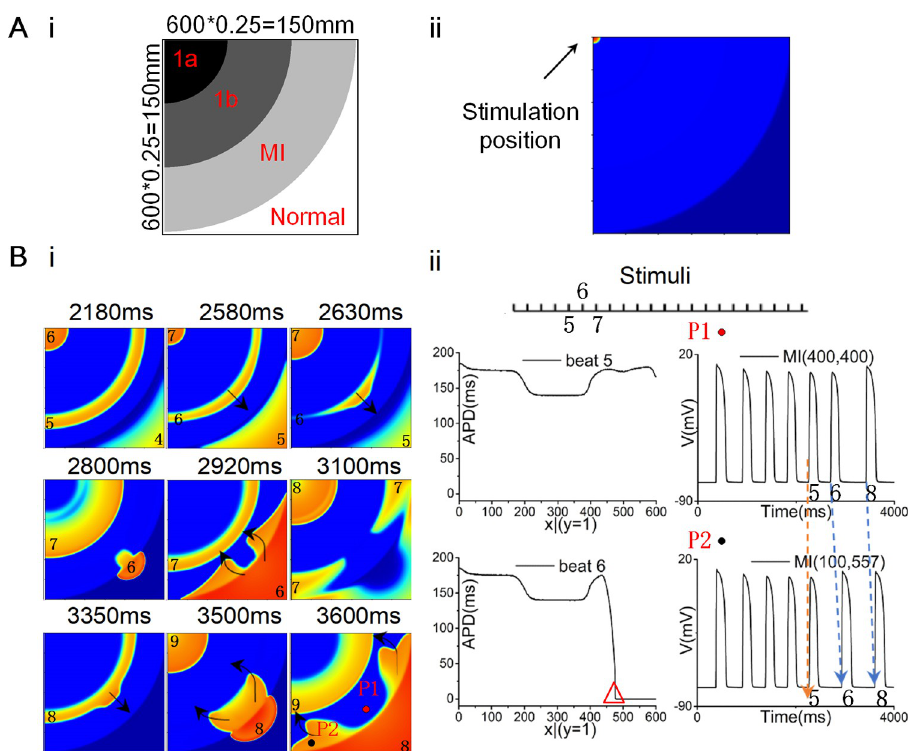
Fig 7. The 2D tissue structure from Fig 1Aii where ischemia 1a, decoupled ischemia 1b and decoupled MI distributed circularly, and wave propagation in the 2D tissue, when the upper left corner stimulation was applied using dynamic stimulation protocol with the stimulation interval of 420ms. (A) (i) The 2D tissue structure and (ii) the location of point stimulation. (B) (i) Wave propagation in the 2D tissue with ischemia 1a, decoupled 1b, and decoupled MI. (ii) APD of all cells along the border of the 2D tissue at the 5th and 6th stimuli and action potentials at points P1 and P2.